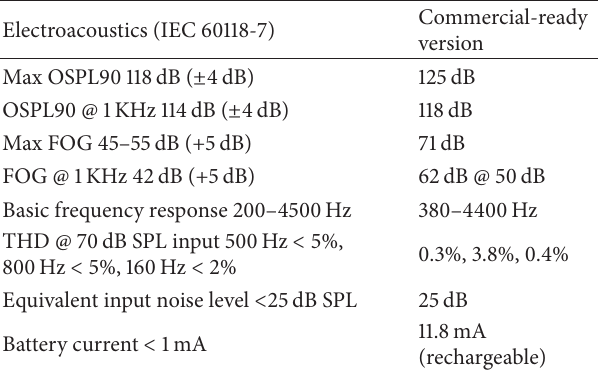
Table 7: Electroacoustics of the commercial-ready version. Electroacoustics (IEC